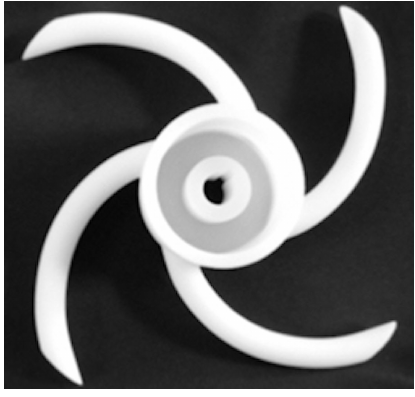
Impeller 4 (I4). Impeller 4 is a modification of Im- peller 2 concept where the pipes that create impeller pas- sages were bended in such way in order to obtain optimal values of the inlet and outlet angles. The number of pas- sages is z = 4, inlet angle β = 50 deg., outlet angle β = 30 1 2 deg.